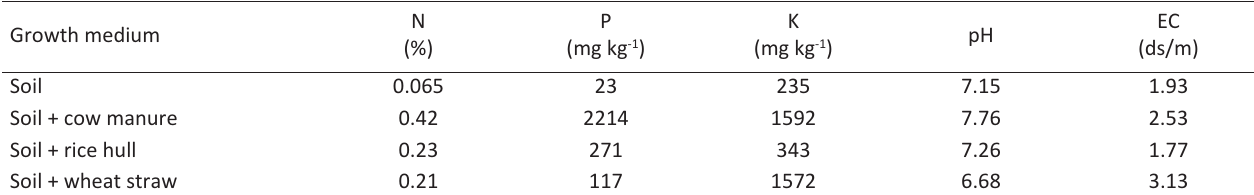
Table 1 ­ Physicochemical properties of the soils used in the experiment